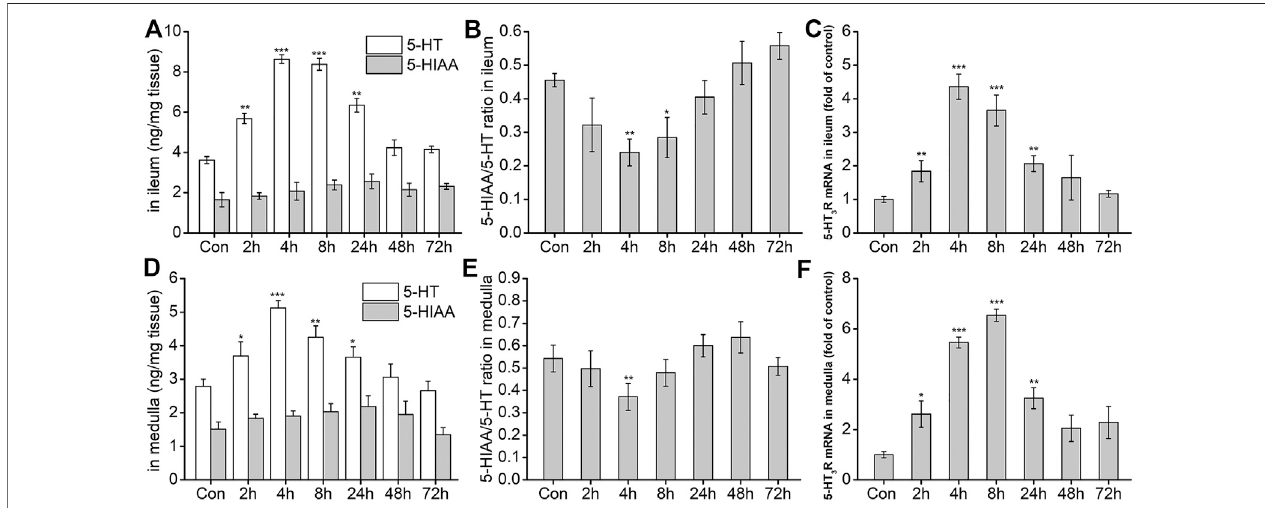
FIGURE5| Theeffect ofDASon 5-HTand 5-HIAA secretion, and 5-HT3receptor (5-HT3R) mRNAexpression inthe ileumand medullaofrats. Rats received DAS (2 mg/kg, p. o.), and their ileum and medulla were collected at 2, 4, 8, 24, 48, and 72 h after treatment (A, B, and C - ileum; D, E, and F - medulla). 5-HT and 5-HIAA concentrations were assessed using HPLC-ECD. The expression of 5-HT 3 receptor mRNA was detected using quantitative real-time PCR. The data are expressed as mean ± SEM. Statistical signi fi cance was assessed using the one-way ANOVA. * p < 0.05, ** p < 0.01, *** p < 0.001 vs. the control group.